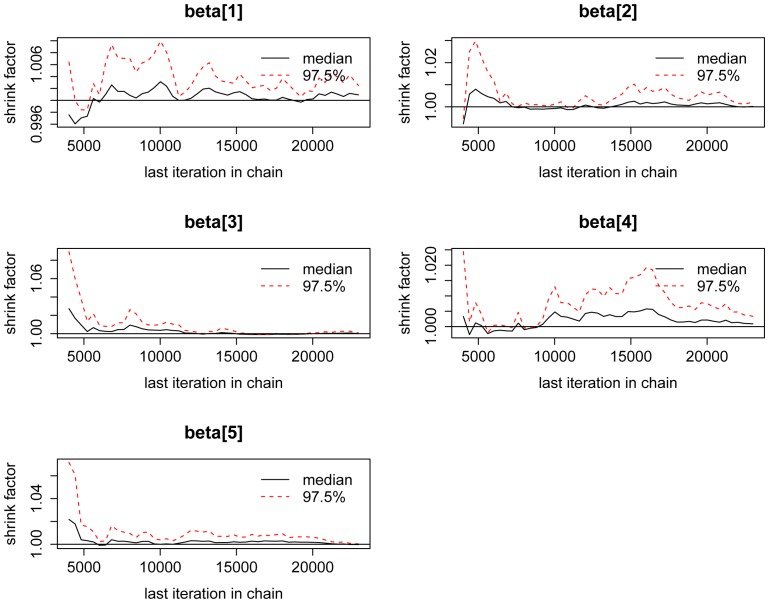
Gelman-Rubin plots.These plots show the development of the potential scale reduction factors (psrf) for modelled parameters over 20,000 iterations of 4 chains. Multivariate psrf = 1.